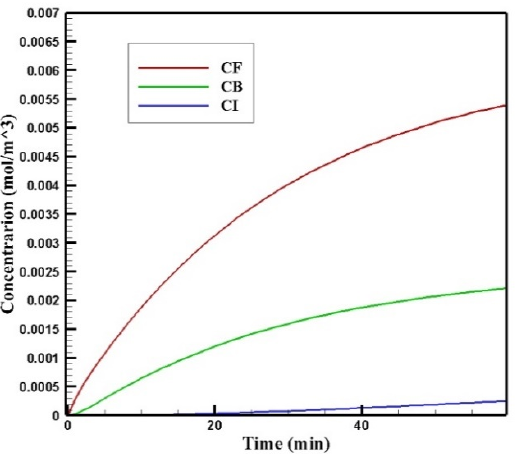
Figure 9. Time profile of the mean concentrations of the free, bound, and internalized drug over 60 min of treatment with a magnetically controlled IP drug targeting system.